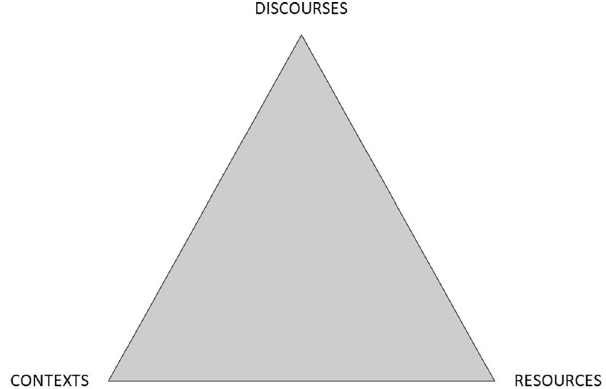
Fig. 1 Franzéns (2010) Power triangle. Used with permission and translated by